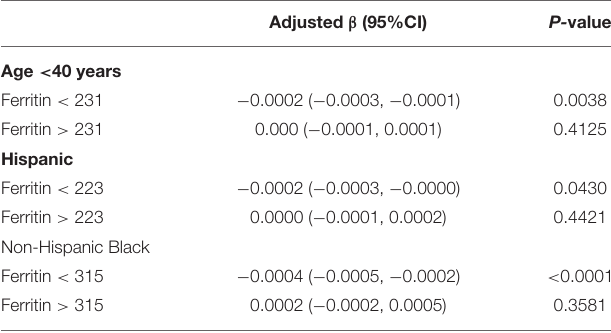
TABLE 4 | Threshold effect analysis of ferritin on ASMI in age < 40 years, Hispanic and Non-Hispanic Black using the two-piecewise linear regression